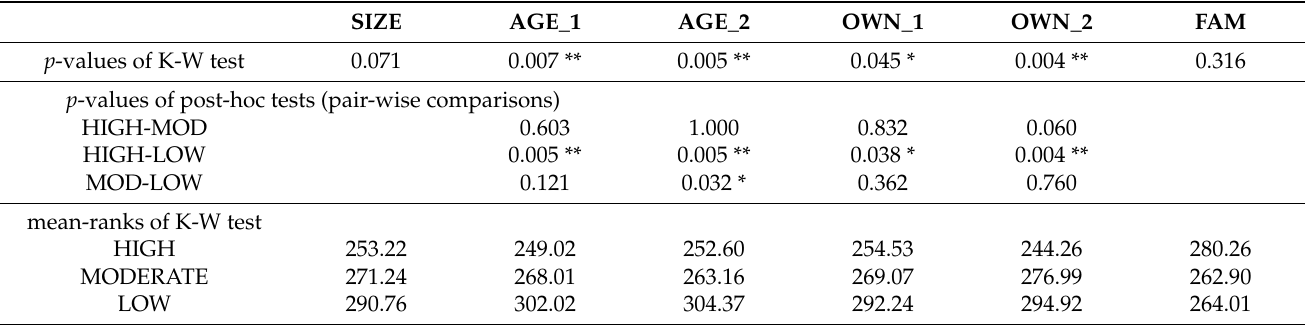
Table 5. Results of non-parametric ANOVA for consolidated COVID-19